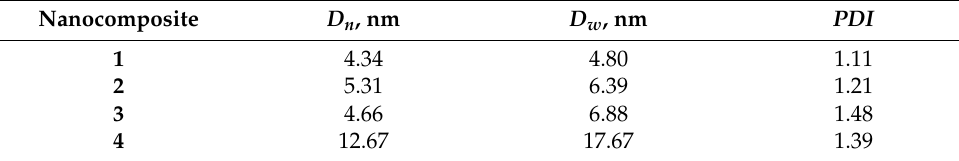
Table 2. Average size and polydispersity of nanoparticles in nanocomposites 1 – 4